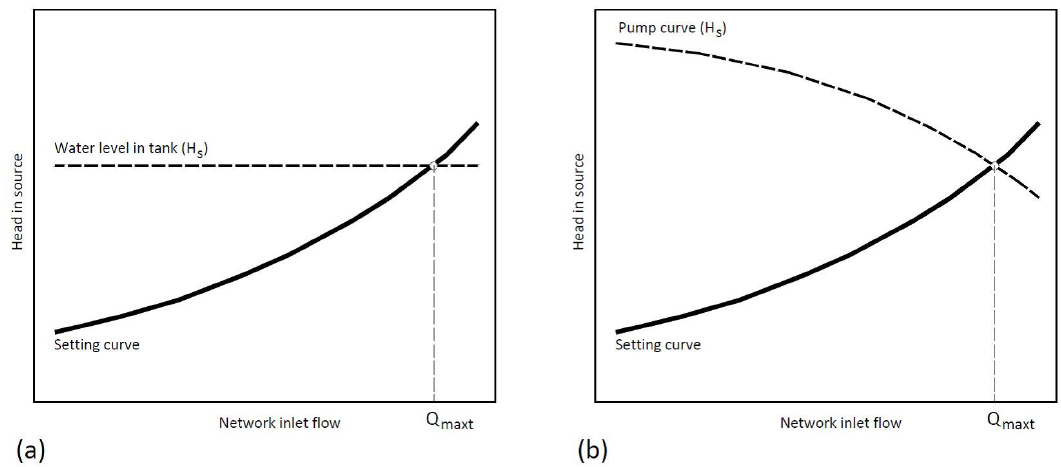
Figure 4. Theoretical maximum flow for: ( a ) a tank or reservoir; and ( b ) a pump.